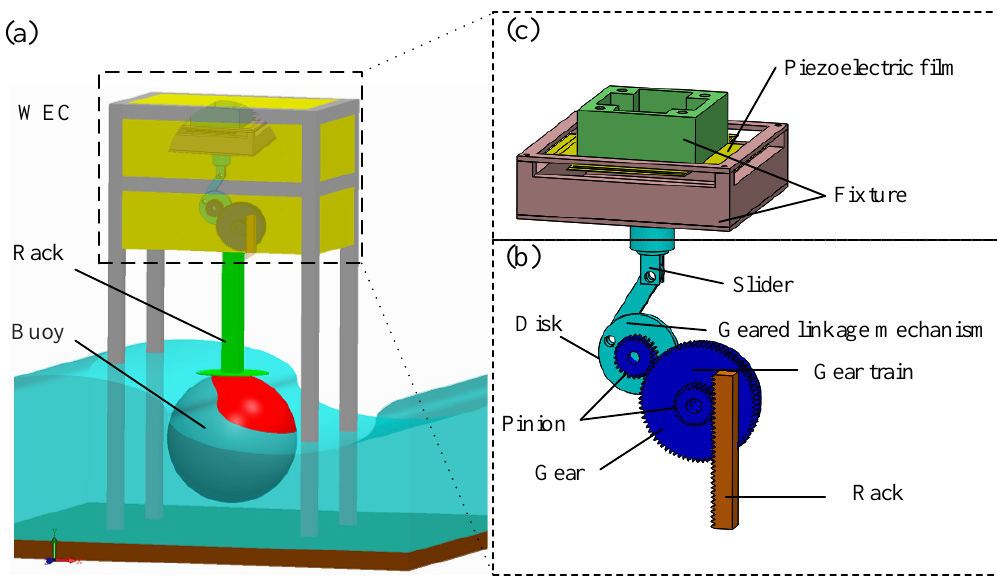
Figure 1. Schematic diagrams of the piezoelectric wave-energy converter. ( a ) Piezoelectric wave-energy converter; ( b ) frequency up-conversion mechanism; ( c ) piezoelectric power-generation component.